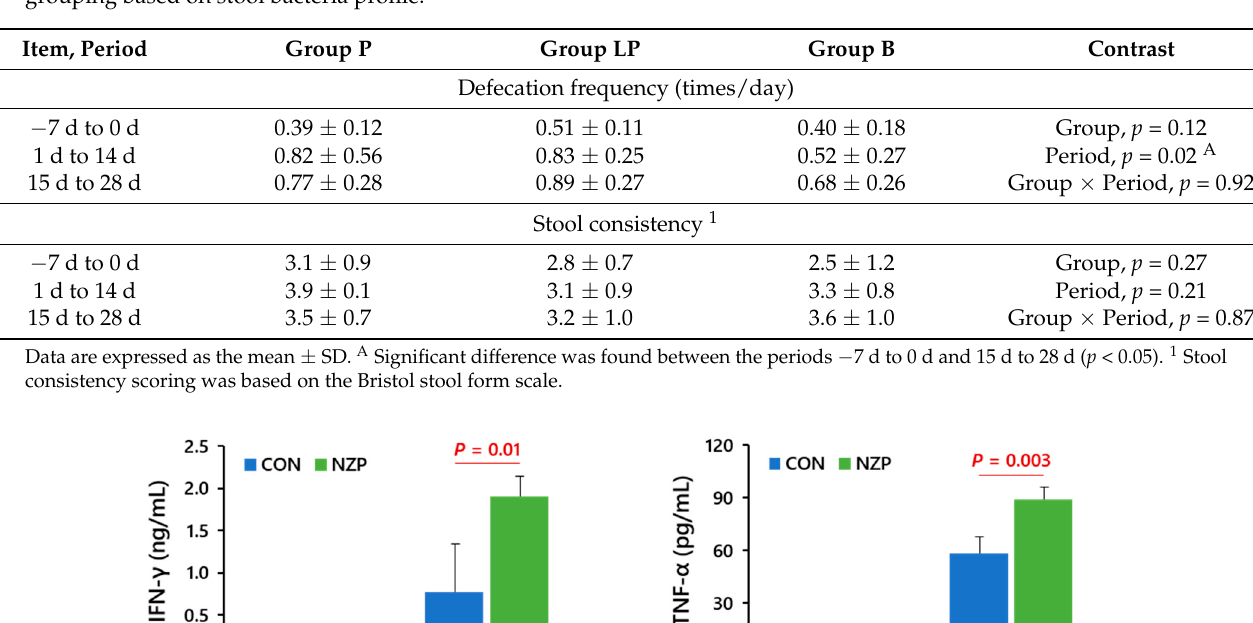
Figure 4. Defecation performance and gut content bacteria characteristics in mice experiment. CON, control group; NZP, treatment group. ( a ) Wet feces weight on the testing day (15 h per collection period). ( b ) Bacterial amounts in three gut content samples (feces sampled at D7, cecum and colon contents sampled at D14). ( c ) Shannon H index of bacterial community structure in the three gut content samples. ( d ) Phylum level distribution of the bacteria in each sampling